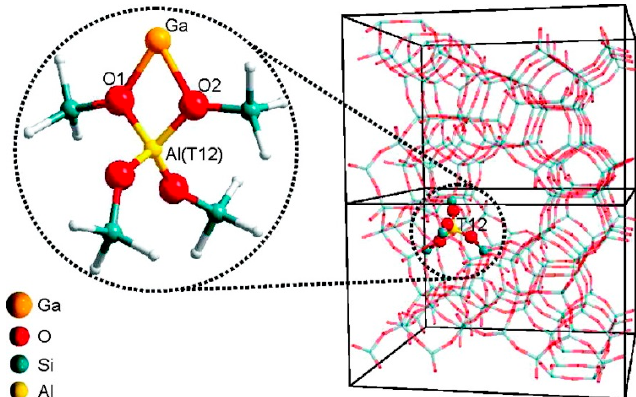
Figure 6. Structure of MFI zeolite and Ga + Z − cluster model used in the DFT calculations. Reprinted with permission from ref [114]. Copyright 2008 American Chemical Society.